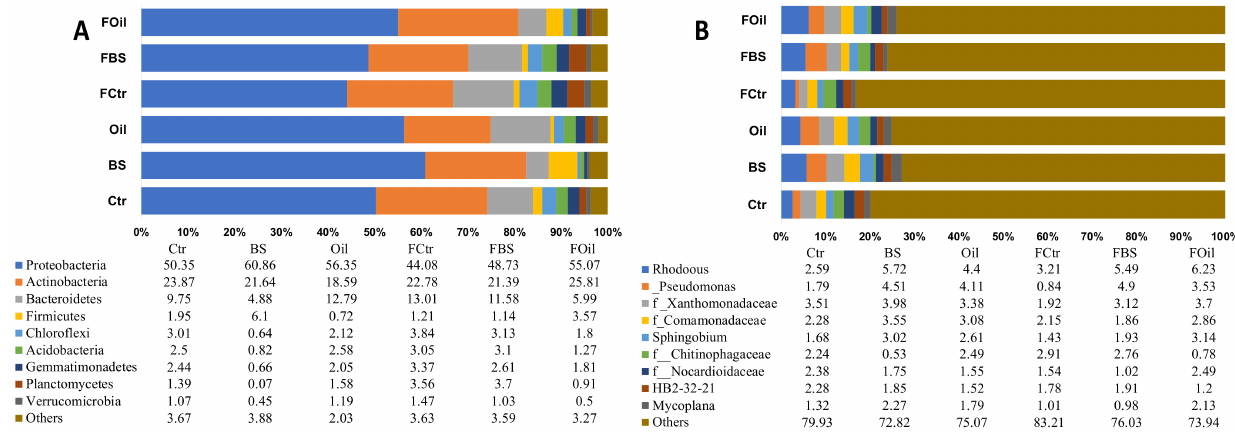
Figure 4. Bar graph representing relative abundance and distribution of 10 most abundant taxa at ( A ) phylum and ( B ) Operational taxonomic unit (OTU) across six treatment conditions. “Others” represent the sum of the remaining